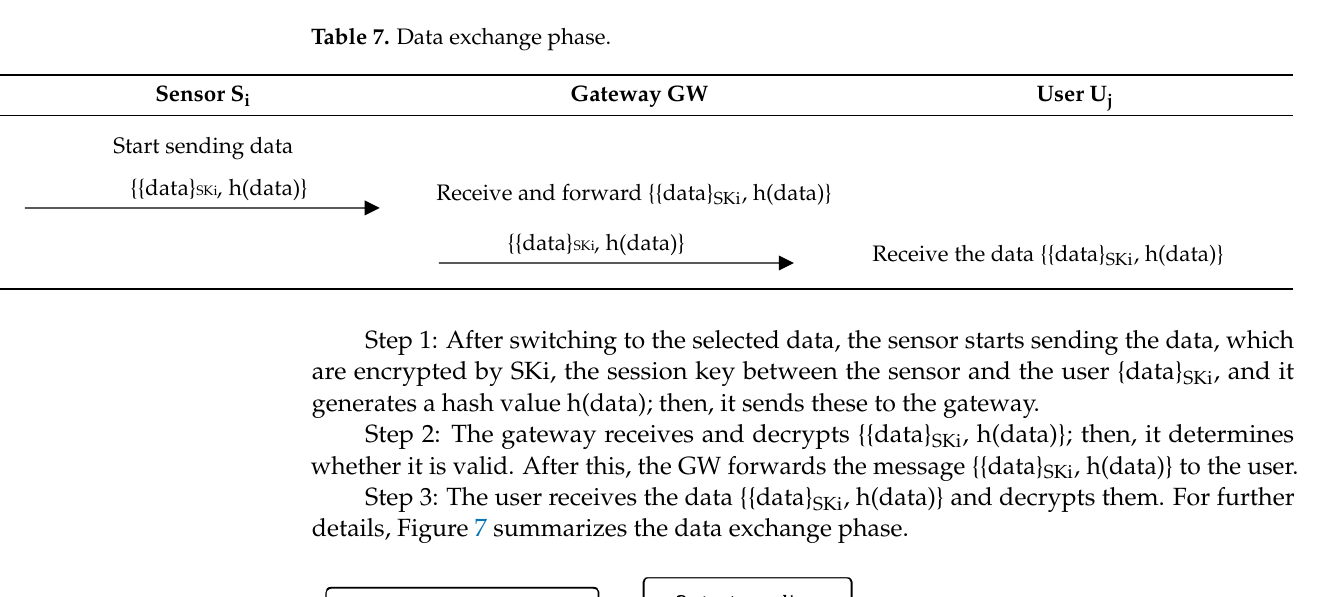
Figure 6. The flow diagram of the control channel exchange phase.